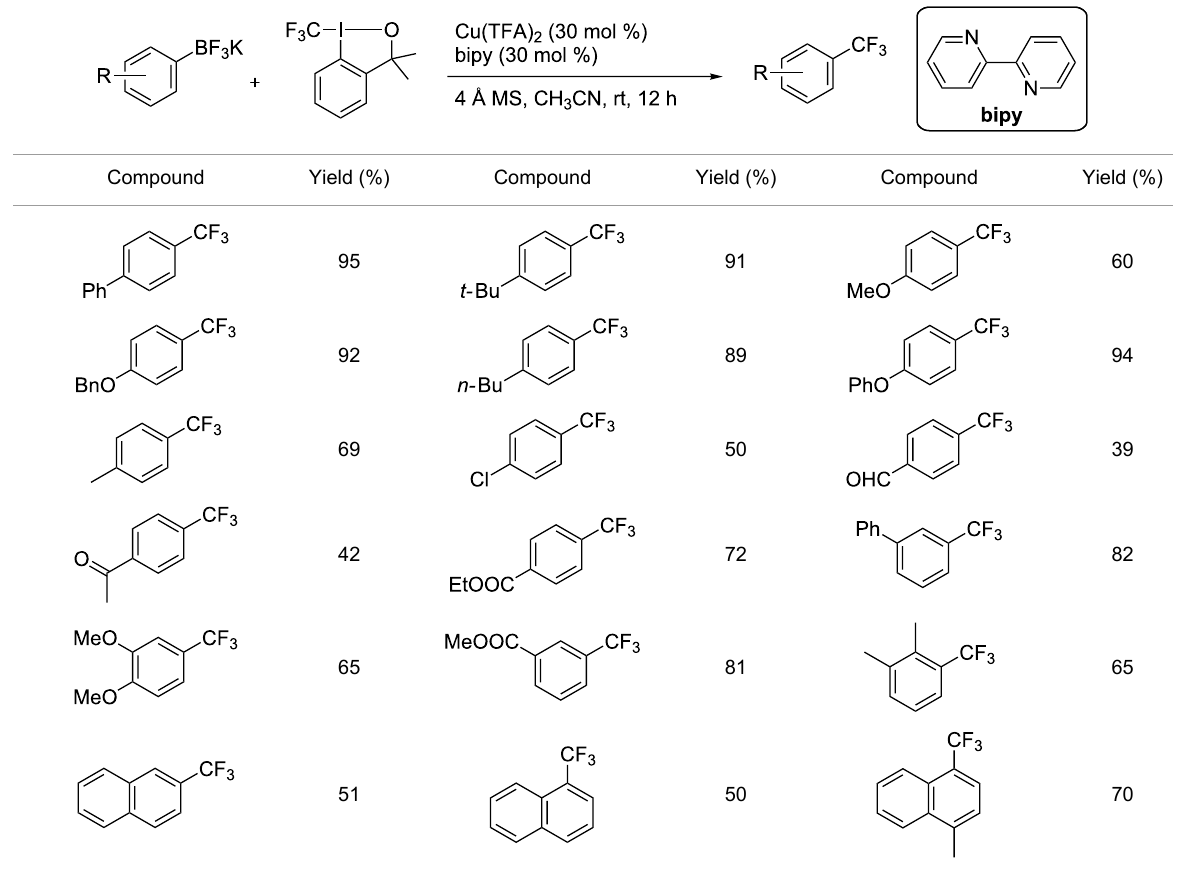
Table 24: Cu-catalyzed trifluoromethylation of aryl- and alkenylboronic acids employing Togni's hypervalent iodine reagent [94]. (continued)